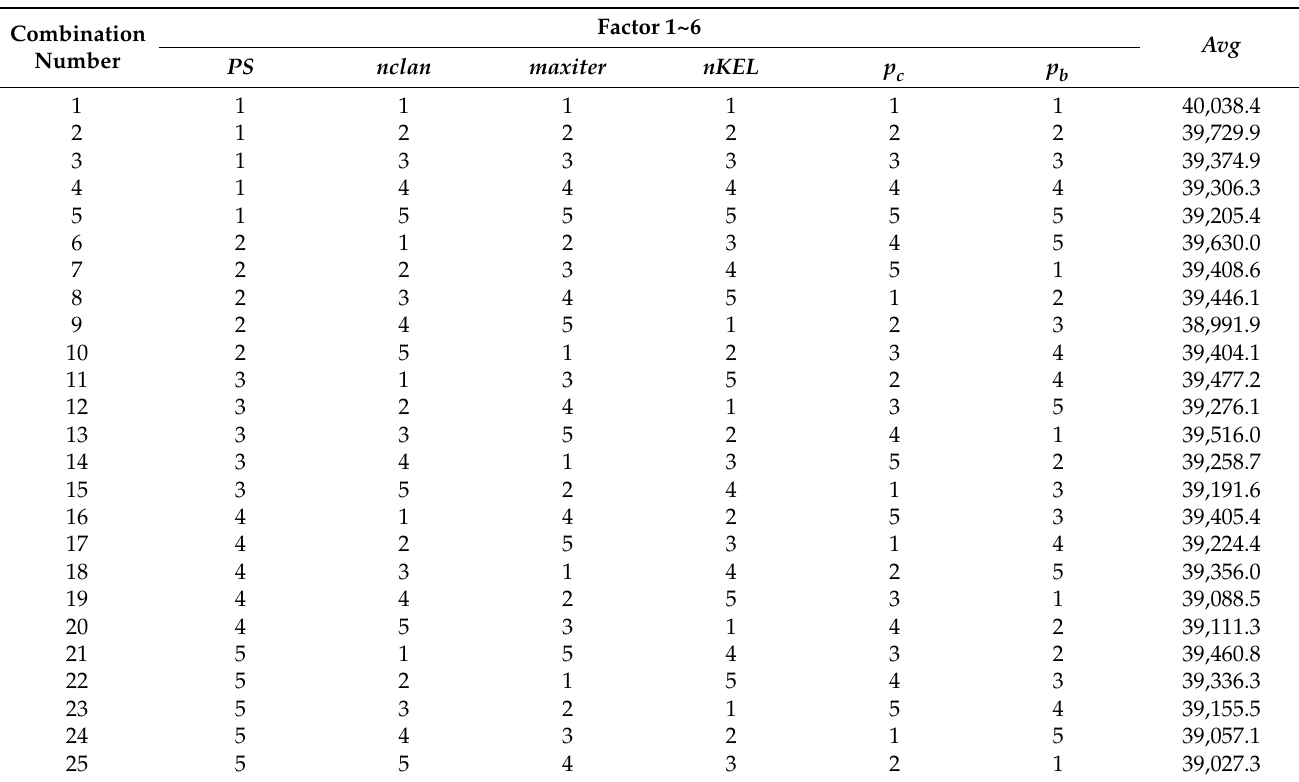
Table 4. Orthogonal array and Avg values.